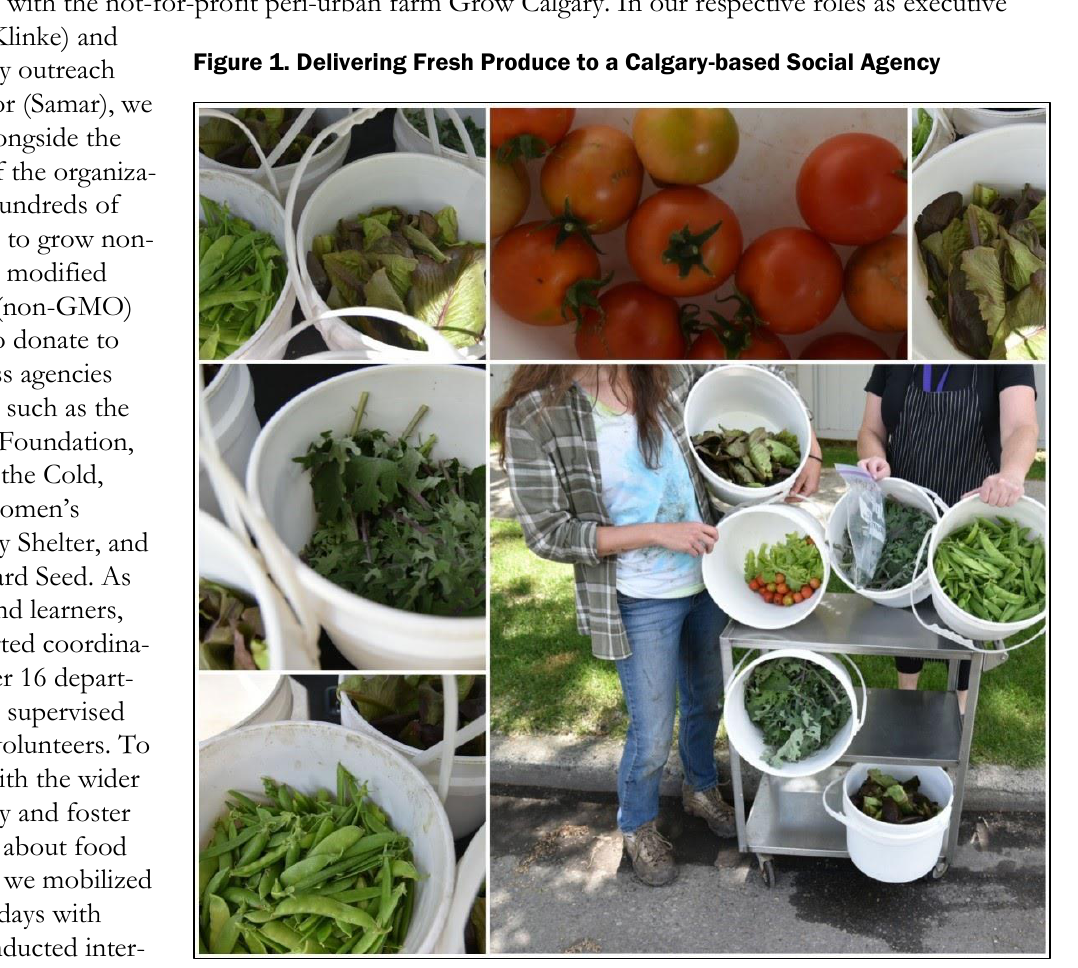
Photos by Veronica Lewis and used with